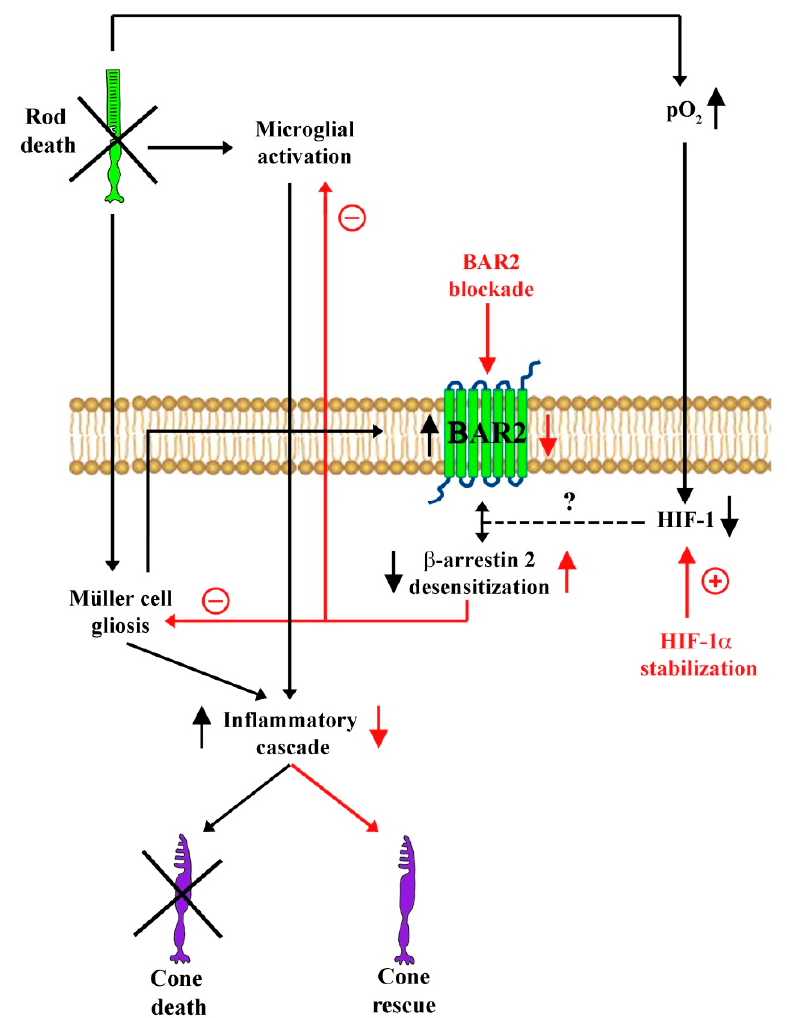
Figure 10. Schematic diagram depicting hypothetical mechanisms through which preventing BAR2 upregulation counteracts cone cell death in a mouse model of retinitis pigmentosa. Genetically determined rod death triggers microglial activation and Müller cell gliosis resulting in BAR2 overexpression in Müller cells likely through the inhibition of desensitization processes. At the same time, the hyperoxic environment produced by photoreceptor death leads to HIF-1 α degradation that contributes to the lack of desensitization. The noxious environment induces cone death, which progressively worsens retinal function. Either BAR2 blockade with propranolol or HIF-1 α stabilization with DMOG recover desensitization processes thus counteracting cone cell death. Black arrows indicate the events consequent to rod degeneration, while red arrows indicate the events consequent to BAR2 blockade and / or HIF-1 α stabilization. The dotted line indicates the hypothetical involvement of HIF-1 in BAR2